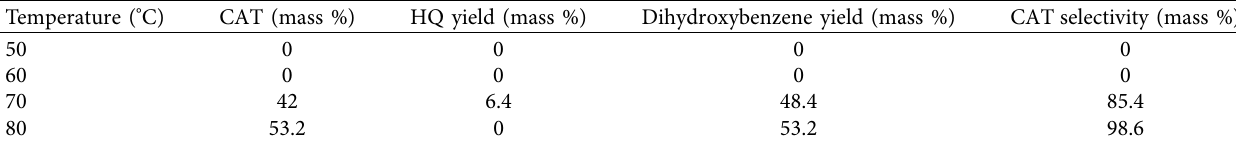
Table 3: Effect of reaction temperature on phenol hydroxylation.